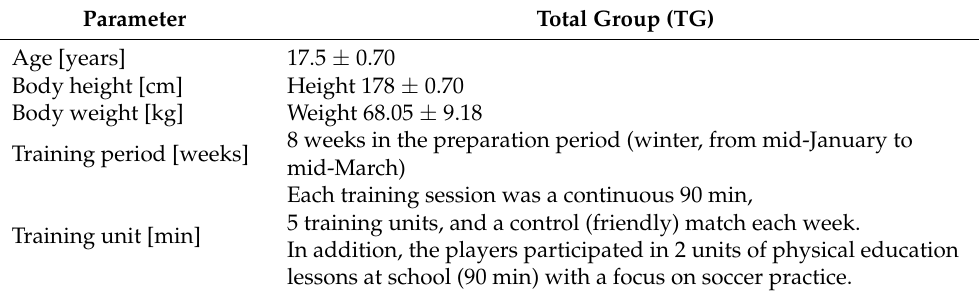
Table 1. Selected biological features of soccer players included in the study and selected training characteristics.